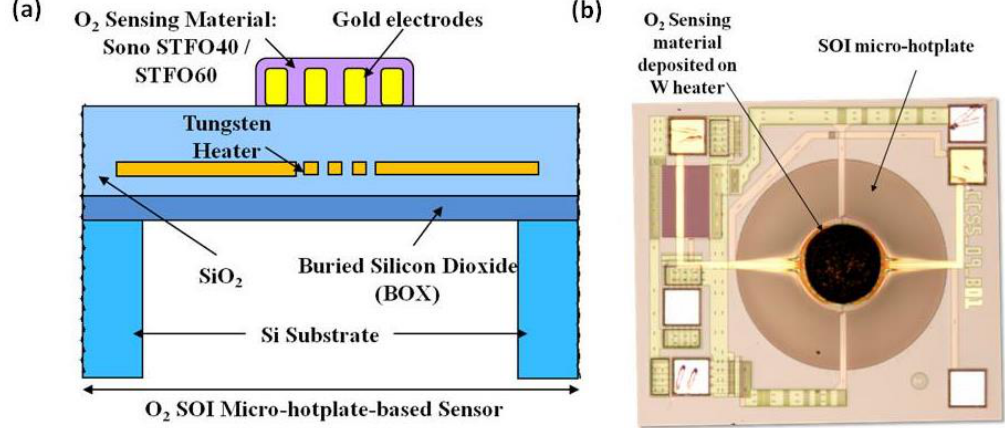
Figure 1. ( a ) O 2 resistive sensor structure employing a CMOS-compatible SOI micro-hotplate as substrate and Sono-STFO40 as sensing layer; ( b ) Top-view of the manufactured O 2 resistive